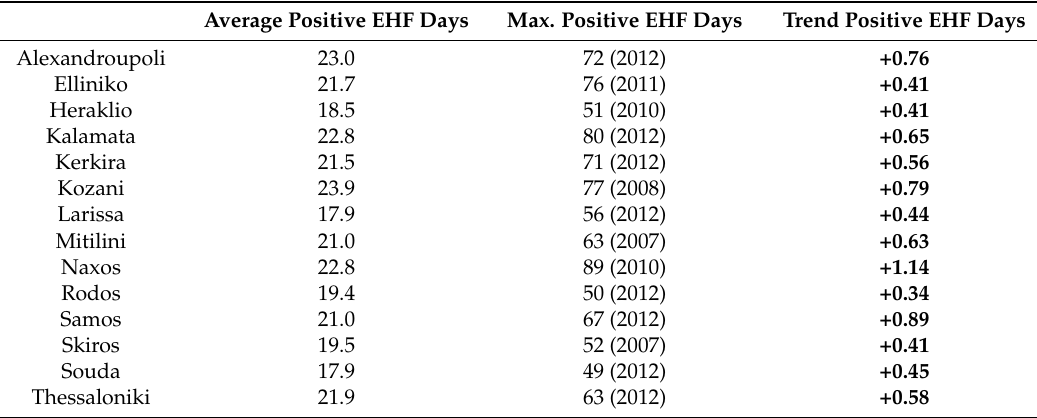
Table 1. Average, maximum and trends of the days with positive EHF values for June, July, August, and September (JJAS) for the period 1958–2012. All the trends were found statistically significant at the 95% level according to Kendall’s tau test. Average Positive EHF Days Max. Positive EHF Days Trend Positive EHF